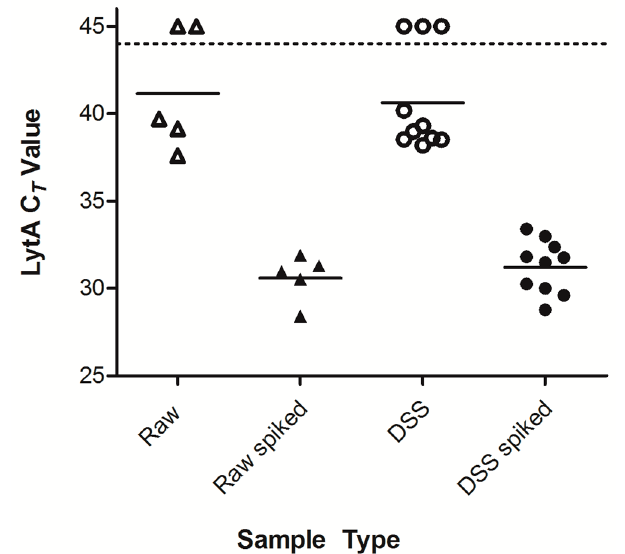
Figure 1. Streptococcus pneumoniae ( S. pneumoniae ) detection in raw saliva versus dried saliva spots (DSS). Saliva samples from 5 donors were spiked with a serotype 19F strain of S. pneumoniae. Both spiked and un-spiked raw saliva and DSS specimens were processed for DNA isolation and quantitative-PCR (qPCR)-based pathogen detection. Each dot represents an individual sample (DSS were performed in duplicate). The dashed line marks the lower limit of detection of qPCR. Differences between un-spiked raw and un-spiked DSS specimens as well as spiked raw and spiked DSS specimens samples are not significant.